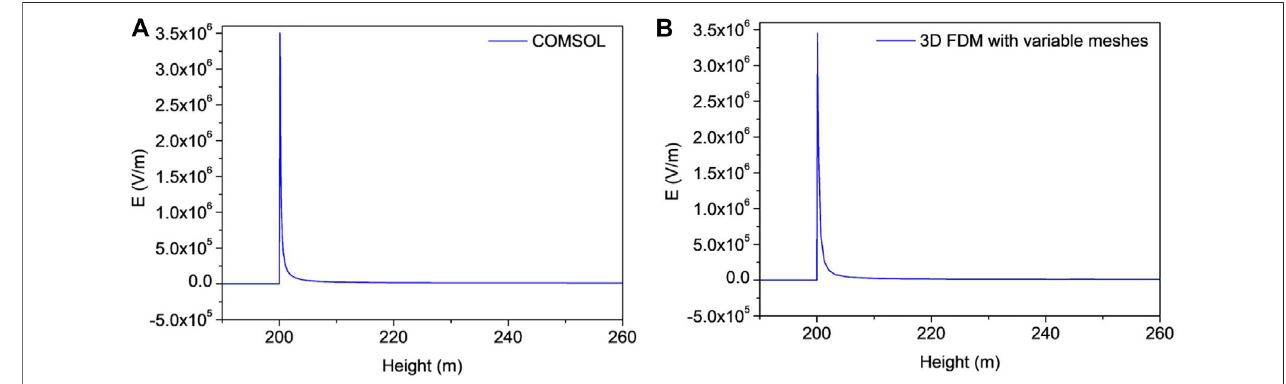
FIGURE3| ComparisonoftherangeofdiffusionofsmallionswhentheenvironmentalE- fi eldreacheditspeak. (A) showstheresultofBecerra ’ smodel, (B) and (C) show results of the proposed model, where directions are divided into the side view and the top view. (D) shows the result of Guo et al. ‘ s model.